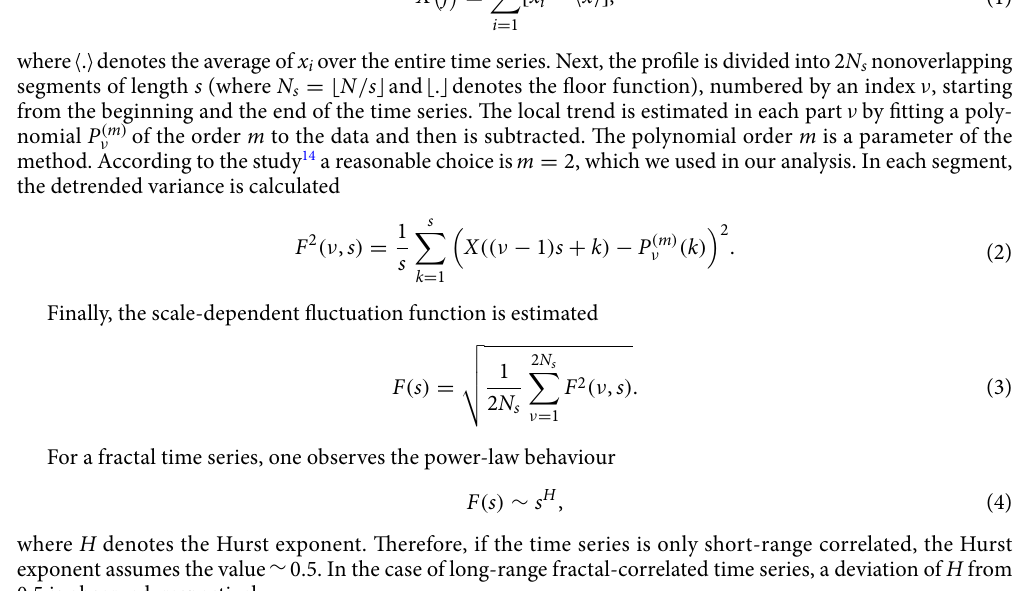
Figure 9. The average of PSD, SEM, and nonverbal global information processing, GLO) and resting-state (RES). (Left) Computed on entire time series. (Right) Computed after dividing time series into the experimental phases: encoding and retrieval. Each line corresponds to a different